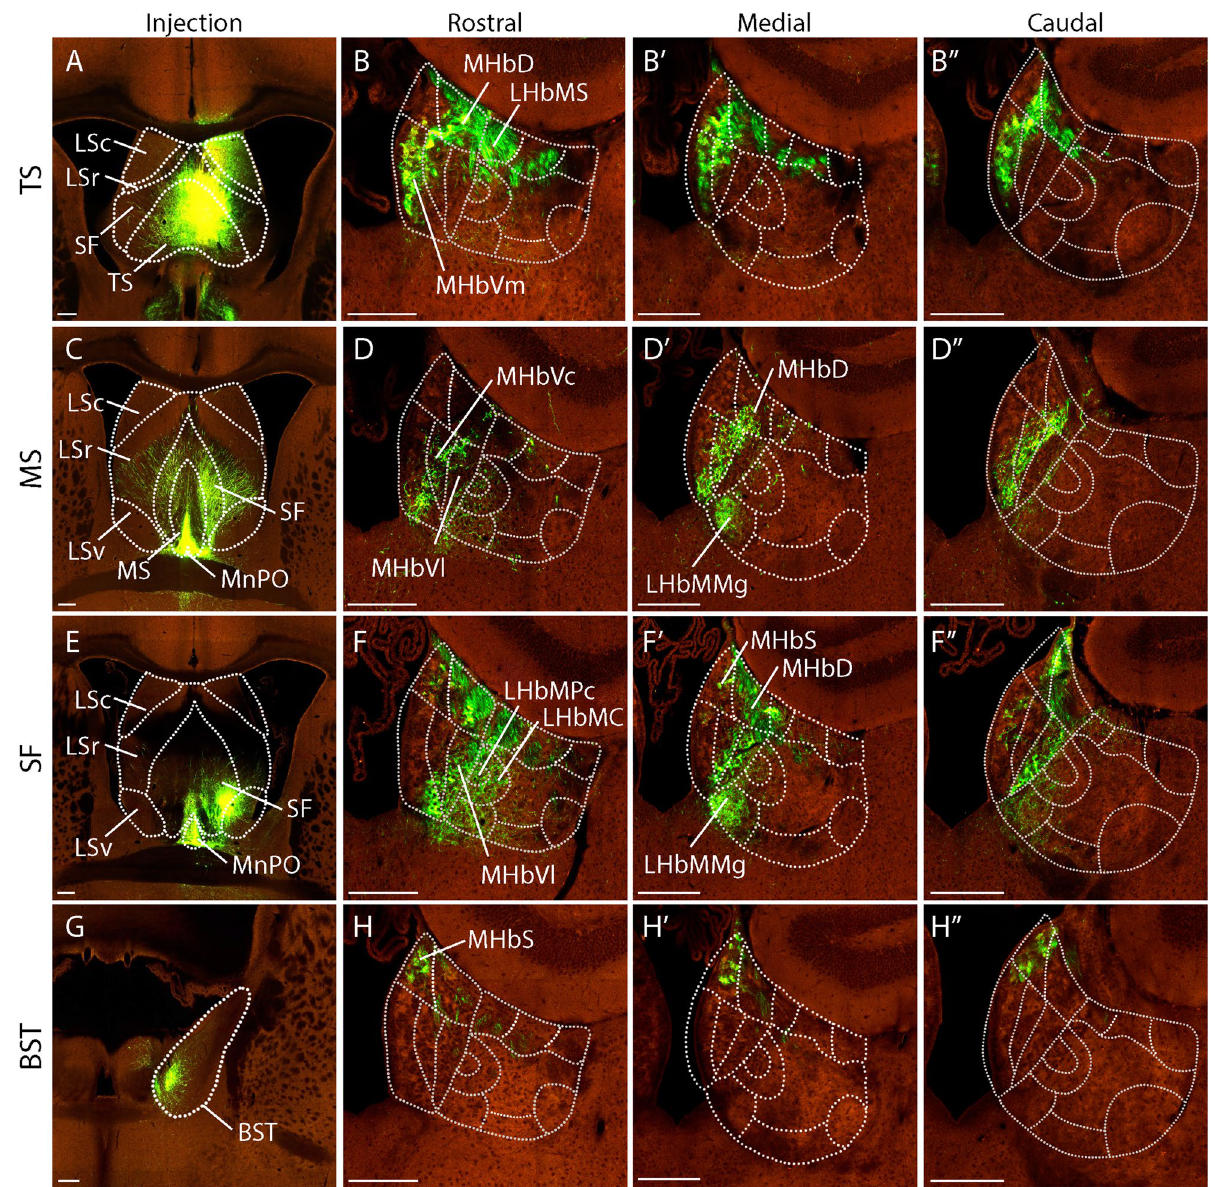
Figure 3. Septal projections to the MHb. ( A ) Injection site in the triangular nucleus of septum (TS; Experiment nº: 125,830,911, identified as Lateral septum rostral part, LSr). ( B – B ”) Adult mouse habenula coronal sections, from rostral to caudal, showing the fiber distribution originated from the TS nucleus. ( C ) Injection site in the medial septal nucleus (MS; Experiment nº: 147,162,736). ( D – D ”) Adult mouse brain coronal sections of the habenula rostral to caudal, displaying the fibers distribution coming from the MS nucleus. ( E ) Injection site in the septofimbrial nucleus (SF; Experiment nº: 554,021,622). ( F – F ”) Adult mouse brain coronal sections of the habenula rostral to caudal, showing the fibers distribution originated from the SF nucleus. ( G ) Injection site in the bed nuclei of the stria terminalis (BST; Experiment: nº 159,433,187. ( H – H ”) Adult mouse brain coronal sections of the habenula rostral to caudal, displaying the fibers distribution coming from the BST nucleus, being the only nucleus that is not from septal territory. Abbreviations: BST: bed nuclei of the stria terminalis; LSc: lateral septal nucleus, caudal part; LSr: lateral septal nucleus, rostral part; MS: medial septal nucleus; LHbLMc: LHbL magnocellular subnucleus; LHbMMg: LHbM marginal subnucleus; LHbMPc: LHbM parvocellular subnucleus; MHbD: MHb dorsal subnucleus; MHbS: MHb superior subnucleus; MHbVc: MHb ventral central subnucleus; MHbVl: MHb ventral lateral subnucleus; MHbVm; MHb ventral medial subnucleus; MnPO: median preoptic nucleus; SF: septofimbrial nucleus; TS: triangular nucleus of septum. Scale bar: 200 μm. Image credit: Allen Institute for Brain Science. [https:// conne ctivi ty. brain- map.